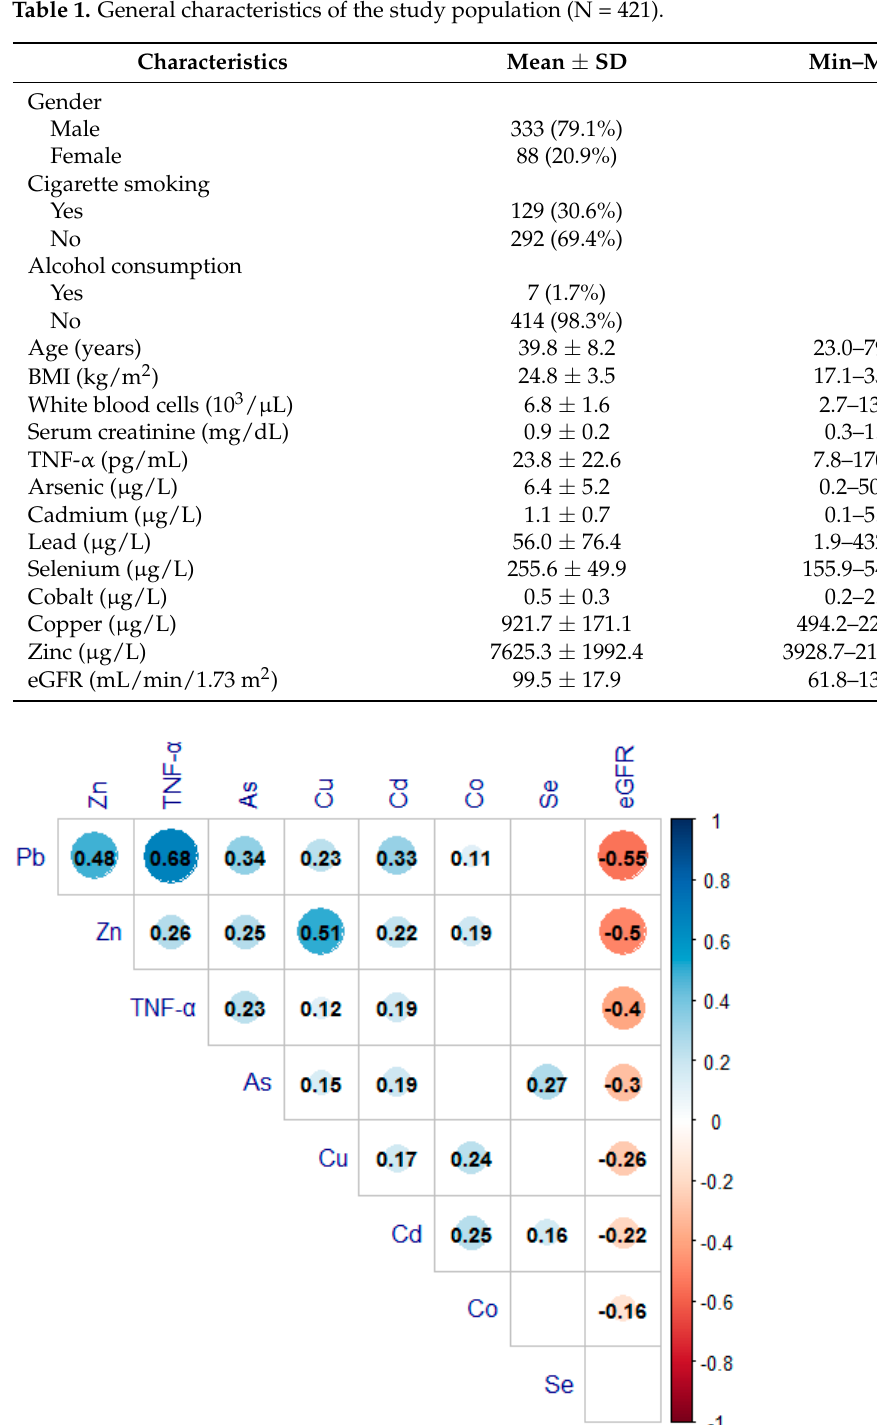
Table 1. General characteristics of the study population (N = 421).